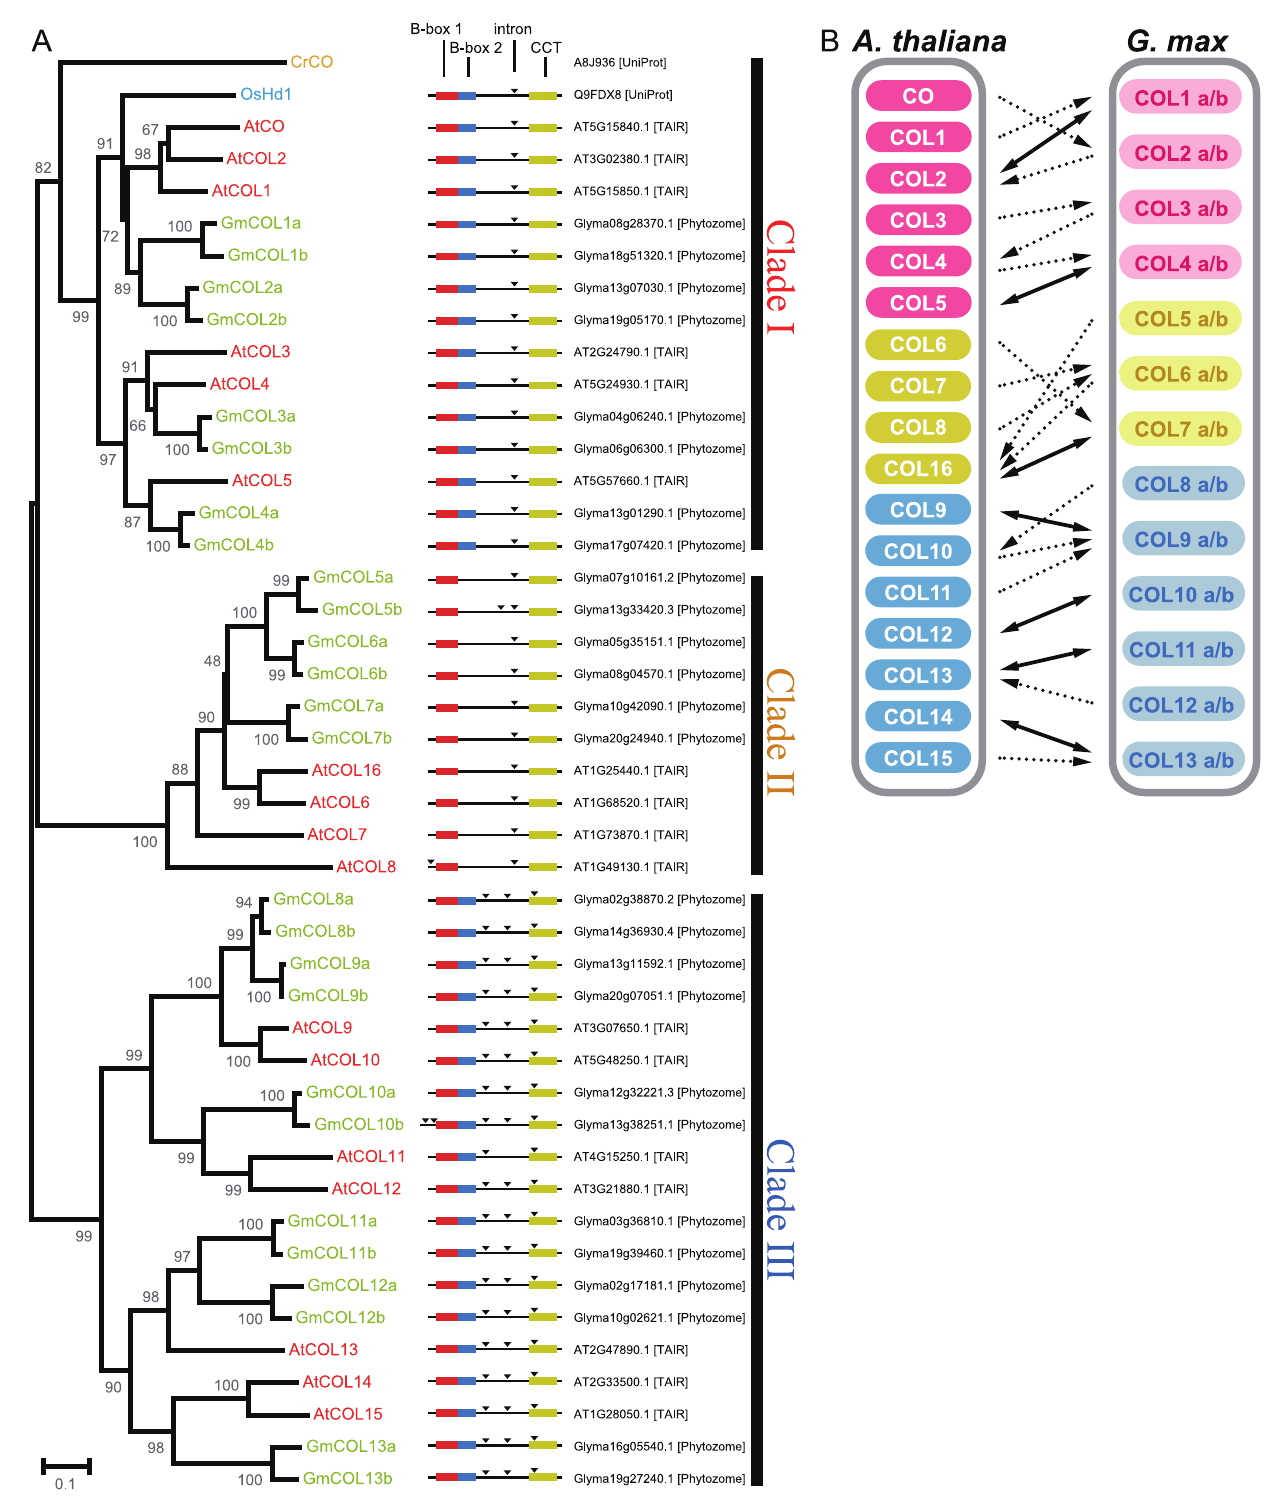
Figure 1. CO homologs in soybean. (A) Phylogenetic analysis of full-length amino acid sequences of CO homologs of soybean (Gm), Arabidopsis (At), rice (Os) and Chlamydomonas reinhardtii (Cr). Numbers at nodes indicate the value of 1,000 bootstrap analyses. The domain structure of B-box 1 (red rectangles), B-box 2 (blue rectangles), CCT (yellow rectangles) and the introns (black triangle) of the genes are shown. Followed are the accession numbers of the proteins and their corresponding databases (in square brackets). (B) BLAST best hits of CO homologs in Arabidopsis ( A. thaliana ) and soybean ( G. max ). The BLAST best hits are shown by dotted lines with an arrow head, and the protein pairs of the reciprocal best hits are shown by lines with double-head arrows.